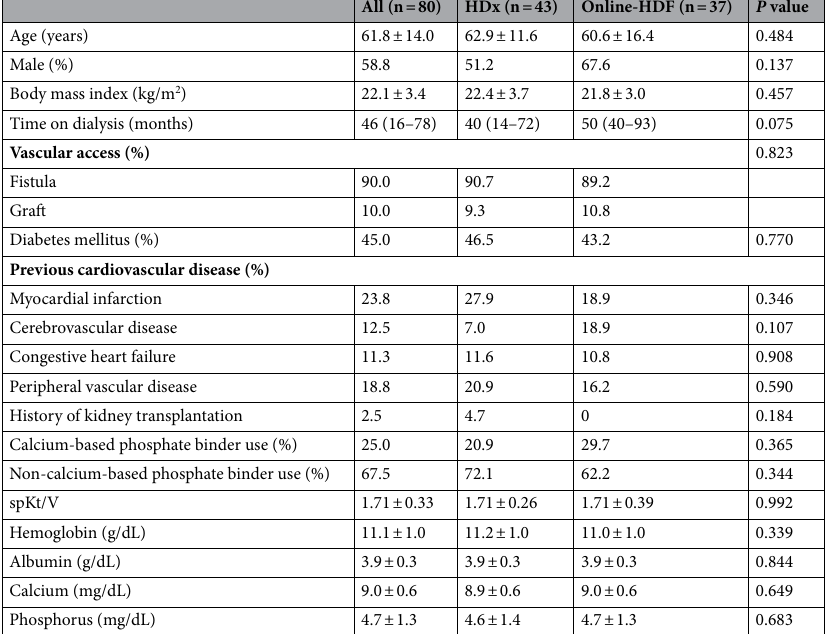
Table 1. Baseline characteristics of the study subjects. Data are expressed as the means ± standard deviations, medians (interquartile range), or proportions, as appropriate. HDx expanded hemodialysis, HDF